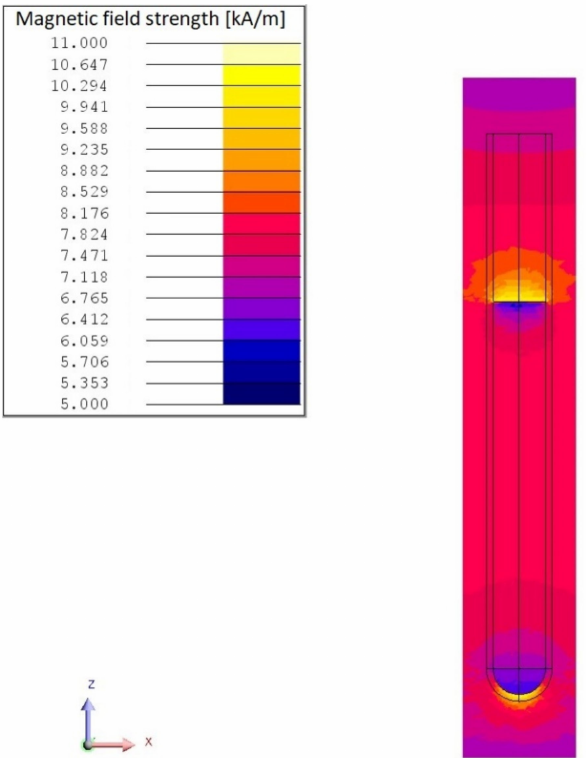
Figure 10. Cross-section of the magnetic field distribution inside the container, at f = 281 kHz and H = 7.83 kA/m.